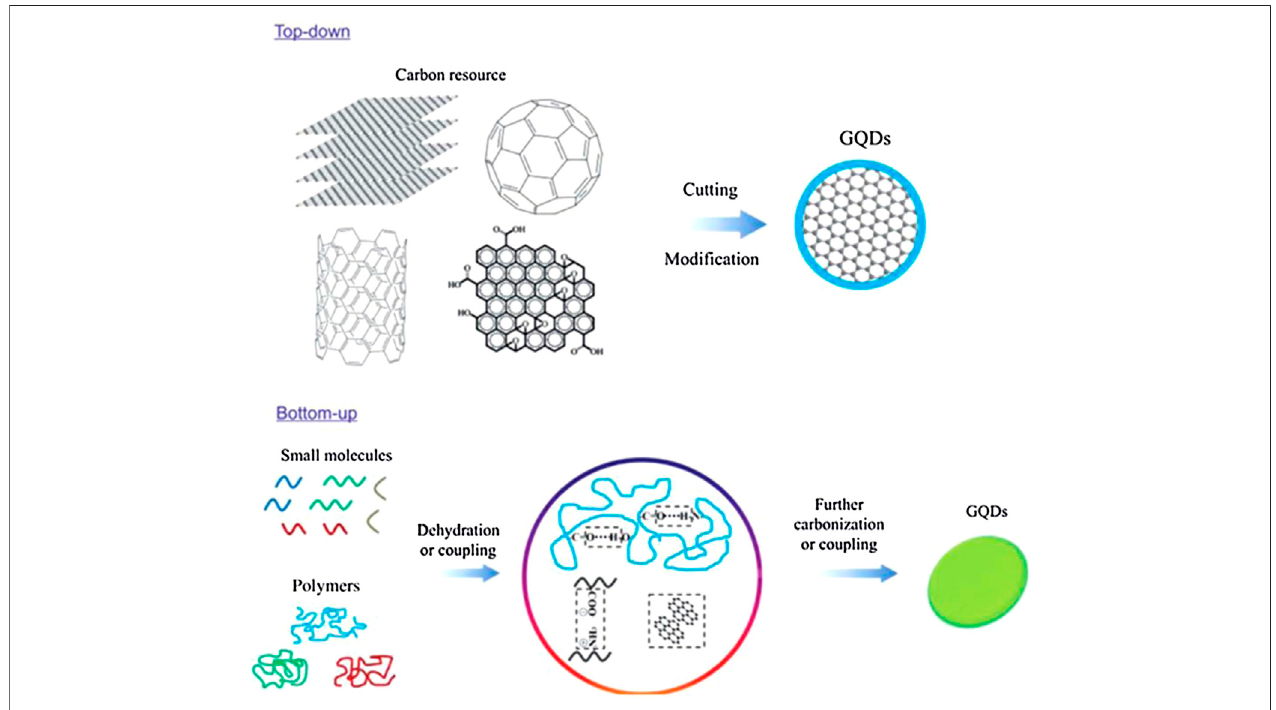
FIGURE 3 | Two approaches to synthesizing GQDs: the “ top-down ” splitting from large molecules and “ bottom – up ” from small molecules (Zhu et al., 2017).